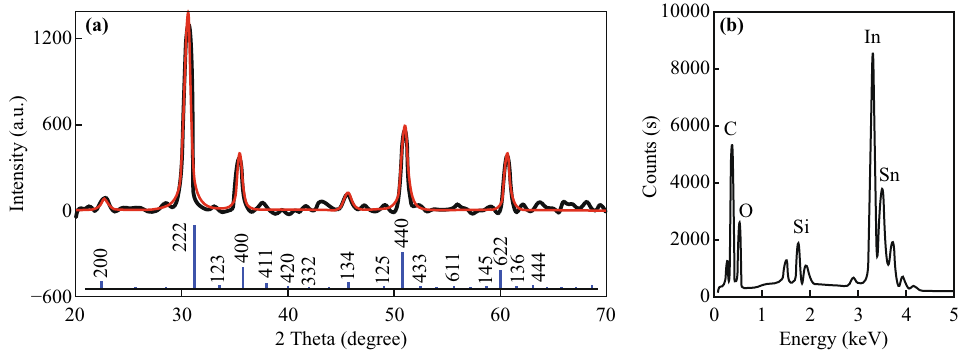
Fig. 3 a XRD pattern of ITO nanoparticles deposited on graphene after annealing at 450 (cid:3) C for 1 h under vacuum (black curve) and Lorentzian fitting curve (red curve). b EDX spectroscopy of ITO nanoparticles deposited on graphene after annealing at 450 (cid:3) C for 1 h under vacuum. (Color figure